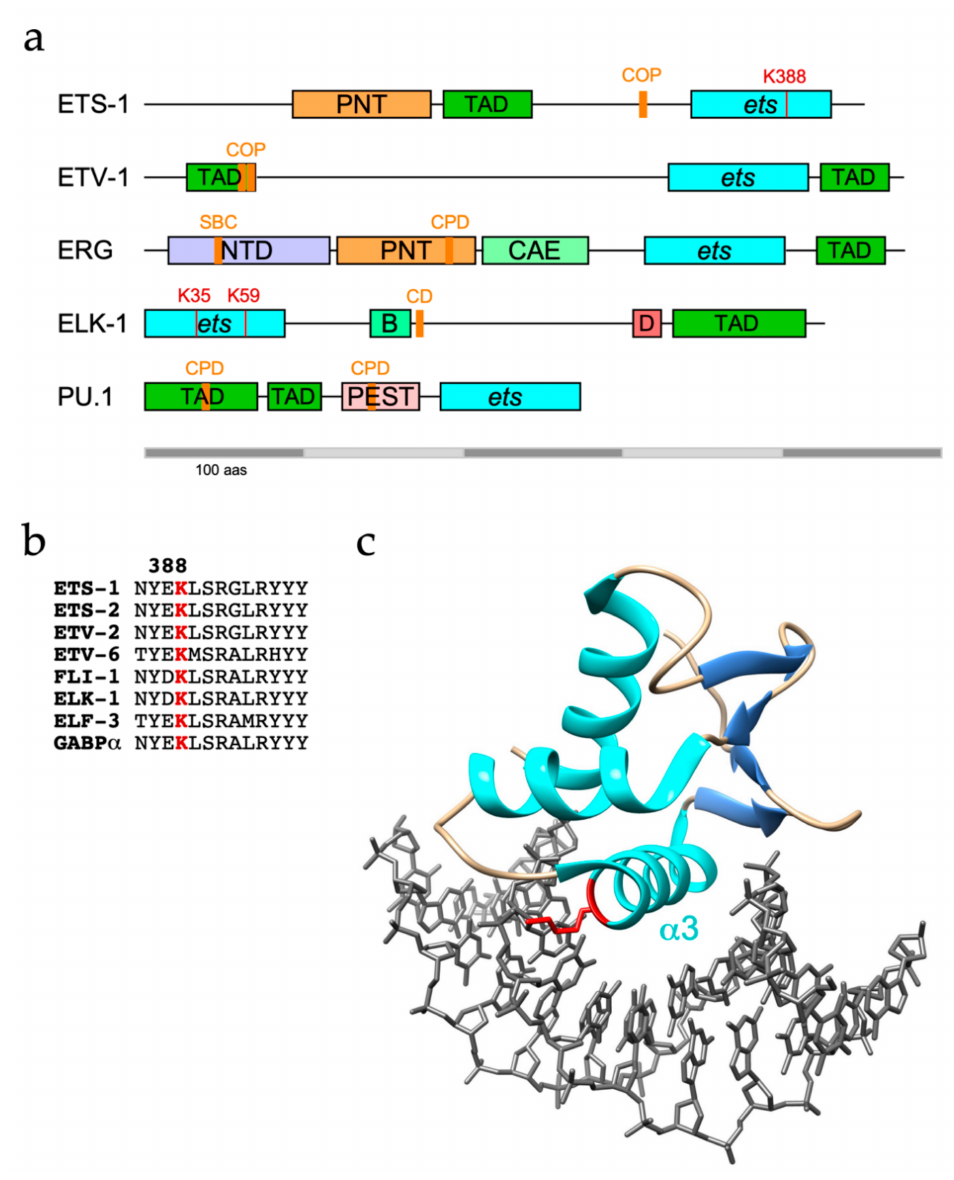
Figure 1. ( a ) Domain organisation of ETS proteins with established ubiquitination modalities in- dicating ubiquitinated lysines confirmed by a combination of mutagenesis and MS in red and characterised degron motifs as orange bars: COP, constitutive photomorphogenesis 1 degron; SBC, SPOP-binding consensus; CPD, CDC4 phospho-degron; CD, cryptic degron. Domains are indicated thus: PNT, pointed (peach); TAD, transactivation (green); ets, ETS (cyan); NTD, N- terminal (lilac); CAE, central alternative exons (light green); B; SRF-interaction (sea green); PEST, proline/glutamate/serine/threonine-rich (pink). ( b ) Alignment of ETS domain α 3 helices indicating conservation (in 25/28 human ETS proteins) of most frequently modified lysine in red, as determined by MS, including large-scale proteomic analysis. See Table 2 for references. ( c ) ETS domain of ELK-1 (PDB: 1DUX) bound to consensus ETS binding site, showing alpha-helices in cyan and beta-strands in blue with α 3 inserted in major groove and sidechain of K59 (K388 in ETS-1) in red making contact with core GGA sequence